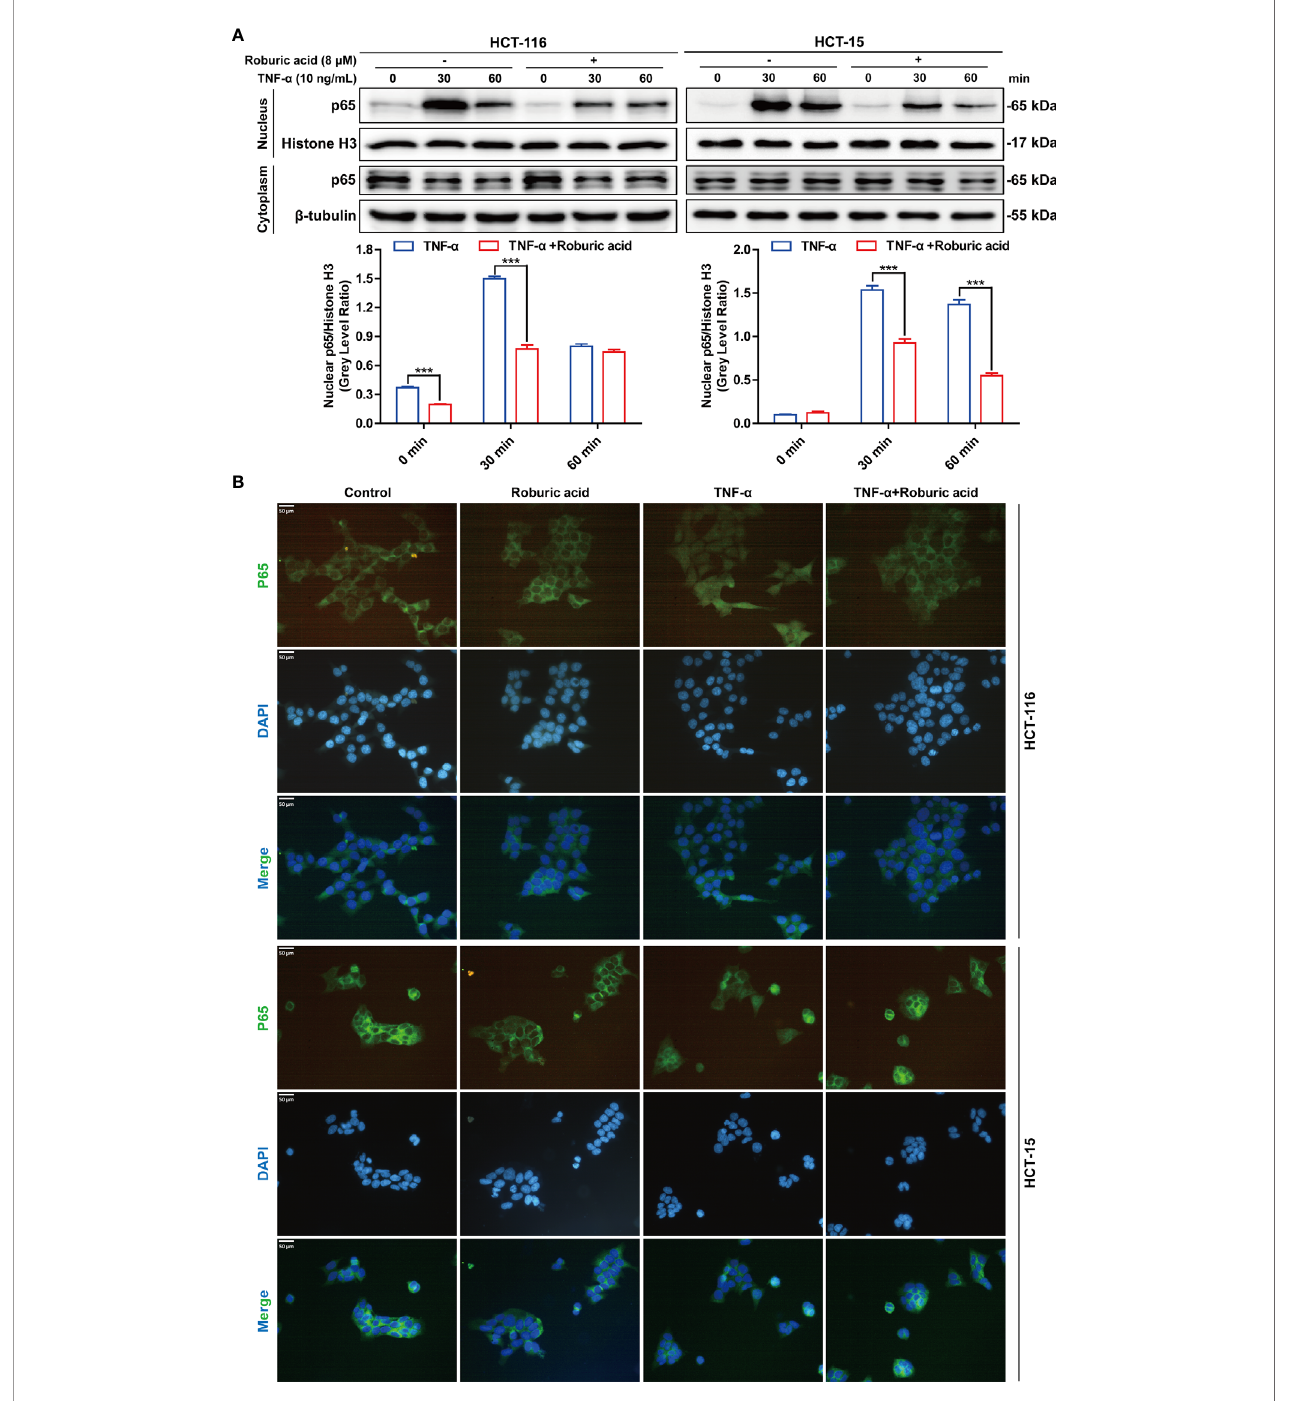
FIGURE 6 | Roburic acid inhibits TNF-induced p65 nuclear translocation in colorectal cancer cells. (A) HCT-116 and HCT-15 cells were treated with roburic acid and TNF as described in Figure 5 , except that the TNF treatment time points were different. Nuclear and cytoplasmic fractions were isolated and subjected to western blotting using an anti-p65 antibody. Beta-tubulin and Histone H3 were respectively used as loading control for the nuclear and cytoplasmic fractions. The gray densities of the bands corresponding to the indicated proteins in HCT-116 and HCT-15 cells were quanti fi ed using AlphaView software. (B) p65 nuclear translocation in HCT-116 and HCT-15 cells was determined by immuno fl uorescence staining. HCT-116 and HCT-15 cells were treated with TNF for 30 min. p65 was detected using the corresponding primary antibody and nuclei were stained with DAPI. The corresponding images (original magni fi cation ×400) were merged using ImageJ software. Representative images are displayed. Data are shown as means ± SEM of three independent replicates. Asterisks indicate signi fi cant differences compared with the TNF treatment at the same time point (*** P <